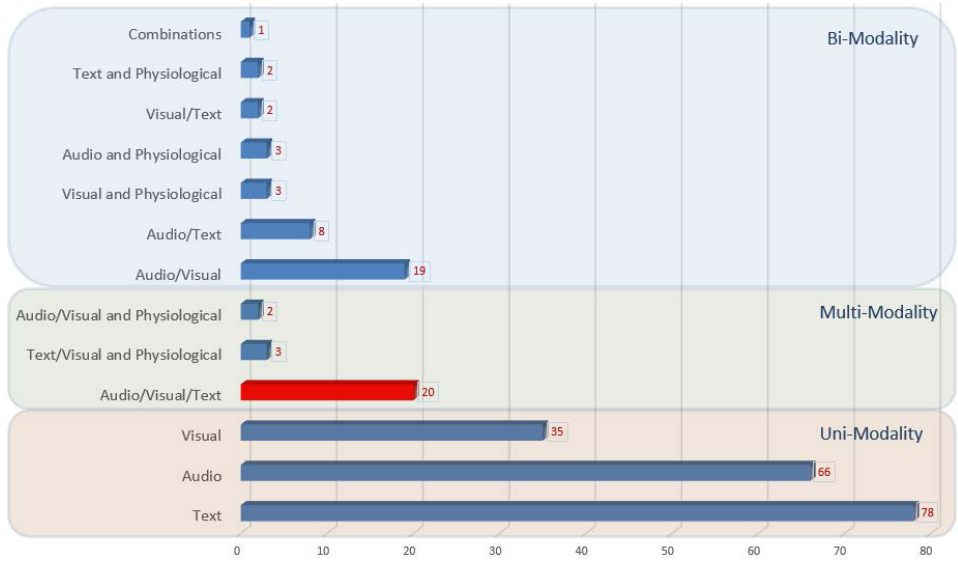
Figure 2. The number of papers per observable cue after the initial screening process. Table 1. The final set of 20 papers that passed the eligibility criteria and were reviewed in